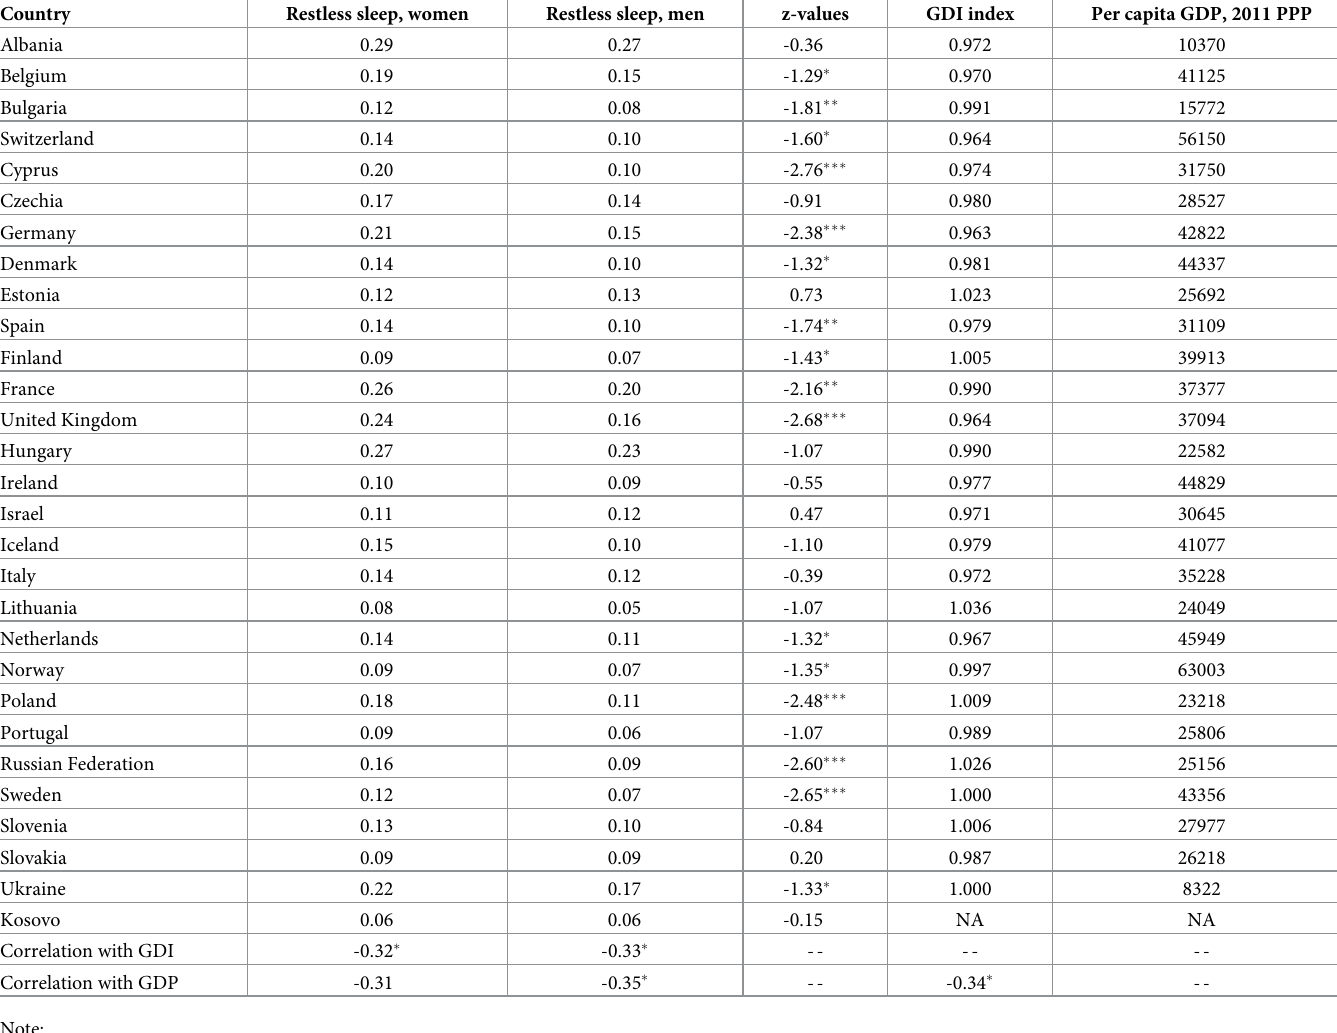
Table 1. Restless sleep by country and country-level